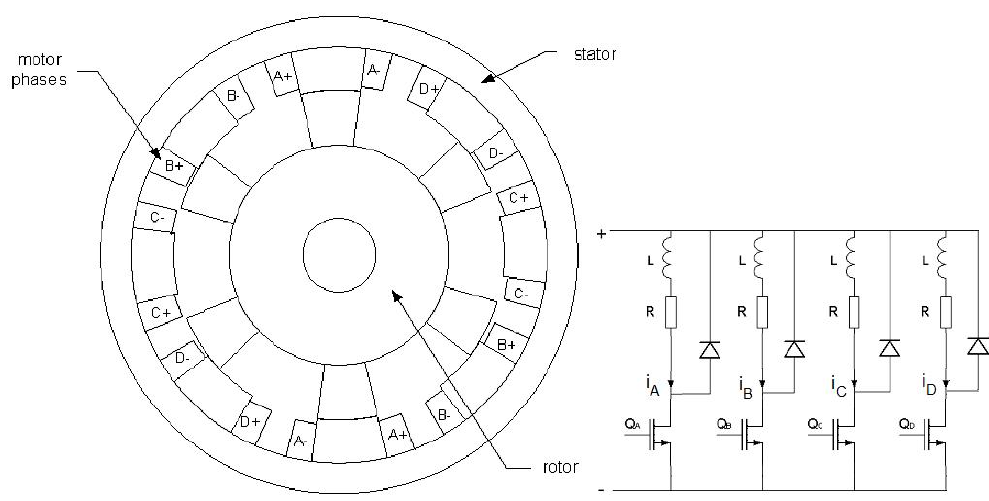
Figure 1. The motor driver electronic circuit. Energies 2017 , 10 , 799